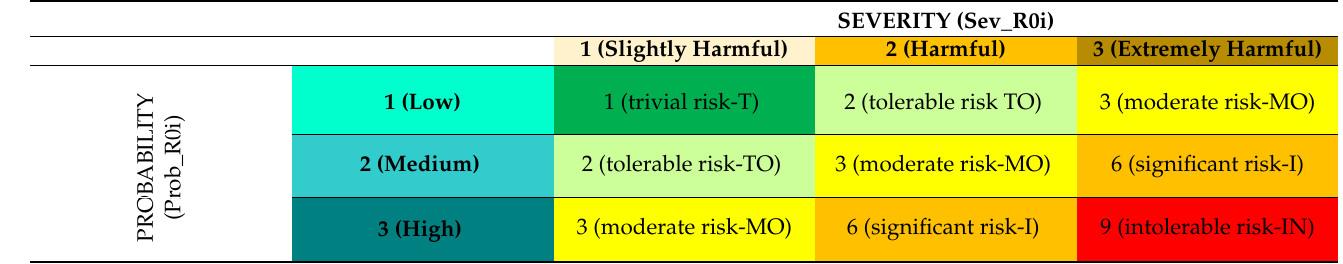
Table 1. Quantitative matrix of risk assessment in the BIM. The evaluated risk rating is in